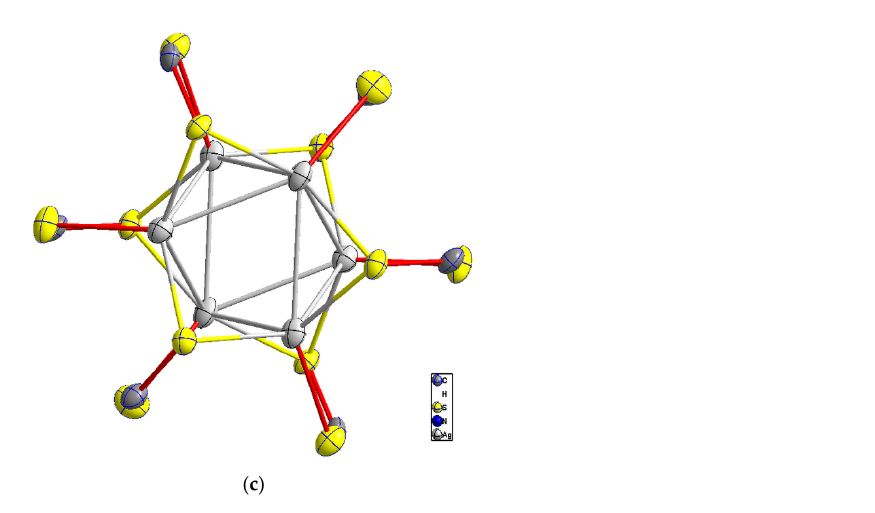
Table 2. Comparison of some selected X-ray crystal data collection and structure refinement param- eters for complex 1 and its polymorph.